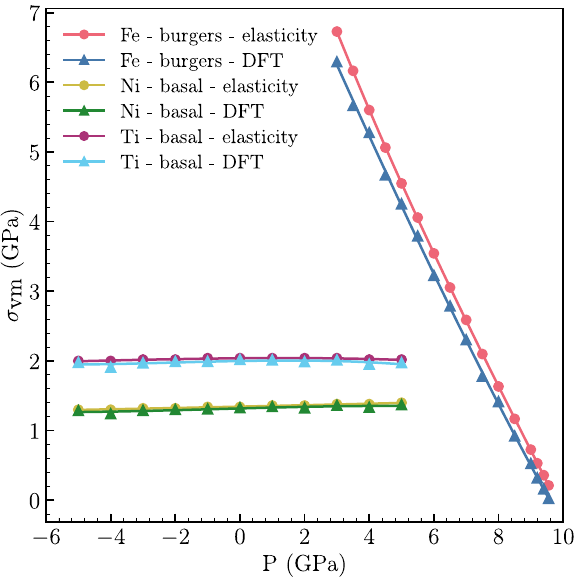
Fig. 3 The minimum von Mises stress for the onset of phase transformation. The points on the PT onset boundaries closest to the p - axis for various pressures are computed for PTs in Fe, Ni and Ti using nonlinear elasticity and